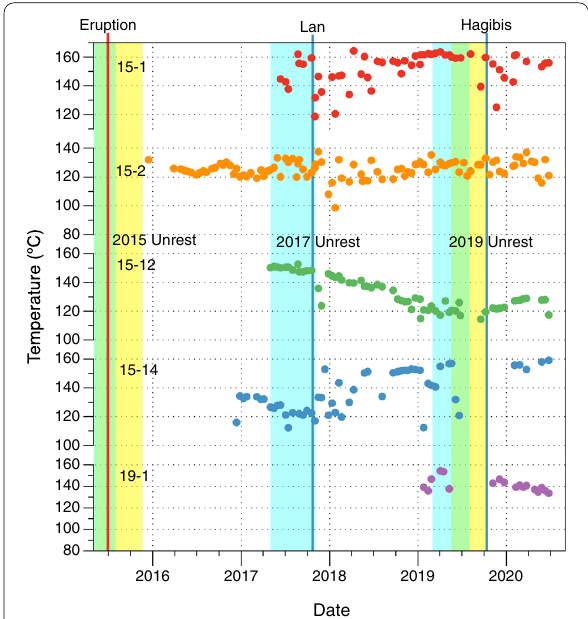
Fig. 6 Temporal changes in temperature of steam emitted from fumaroles in Owakudani. The durations of volcanic unrest episodes are shown as shaded yellow (VAL2 or more) and blue (baseline across the volcano is increasing). See caption of Fig. 3 for details. Timing of heavy rains due to typhoons, which seem to have temporarily lowered steam temperature from some fumaroles, is also shown (Lan on October 23 in 2017 and Hagibis on October 18, 2019). The location of fumaroles is shown in Fig. 1c